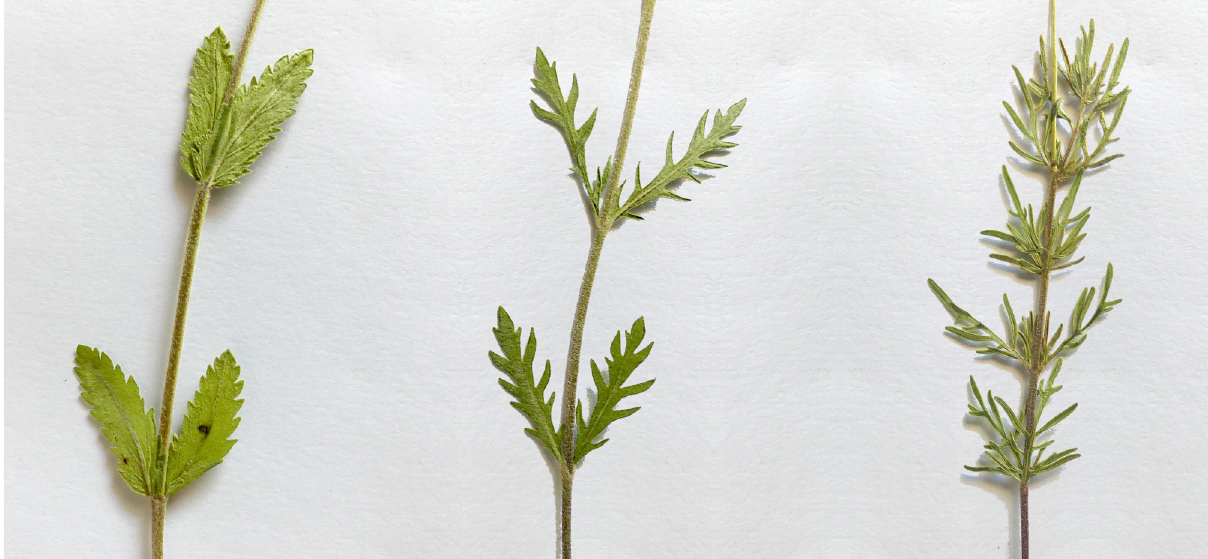
Figure 1. Leaf morphology (central segment of the stem). Left to right: Veronica orsiniana , Veronica × gundisalvi and Veronica tenuifolia subsp. tenuifolia